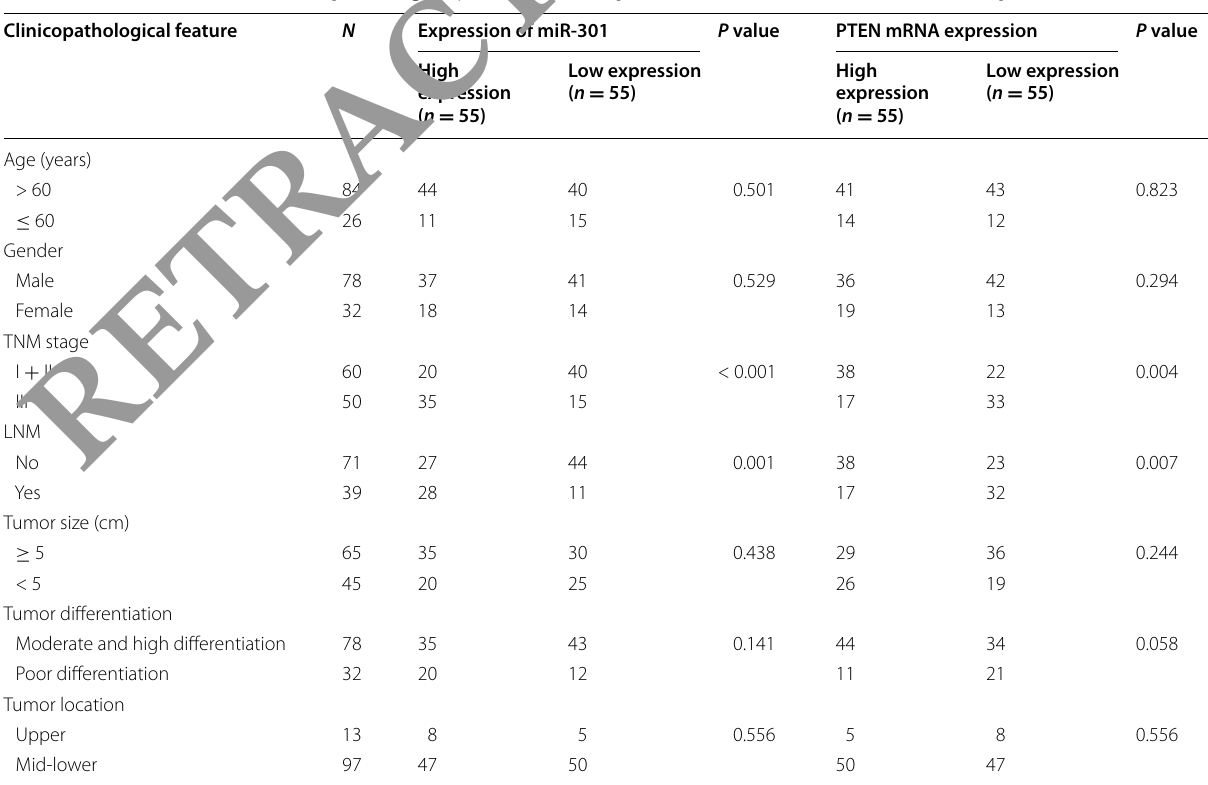
Fig. 1 MiR-301 is highly expressed, while PTEN is poorly expressed in ESCC tissues and cells. a Expression of miR-301 and mRNA expression of PTEN in the ESCC tissue detected using RT-qPCR; b protein expression of PTEN in the ESCC tissue detected using Western blot analysis; c protein bands of PTEN in the ESCC tissue in Western blot analysis; d expression of miR-301 and mRNA expression of PTEN in ESCC cell line detected using RT-qPCR; e protein expression of PTEN in ESCC cell line detected using Western blot analysis; f protein bands of PTEN in Western blot analysis. * P < 0.05 versus HEEC. Data were expressed as mean standard deviation, and the t test was performed for comparisons between two groups ±